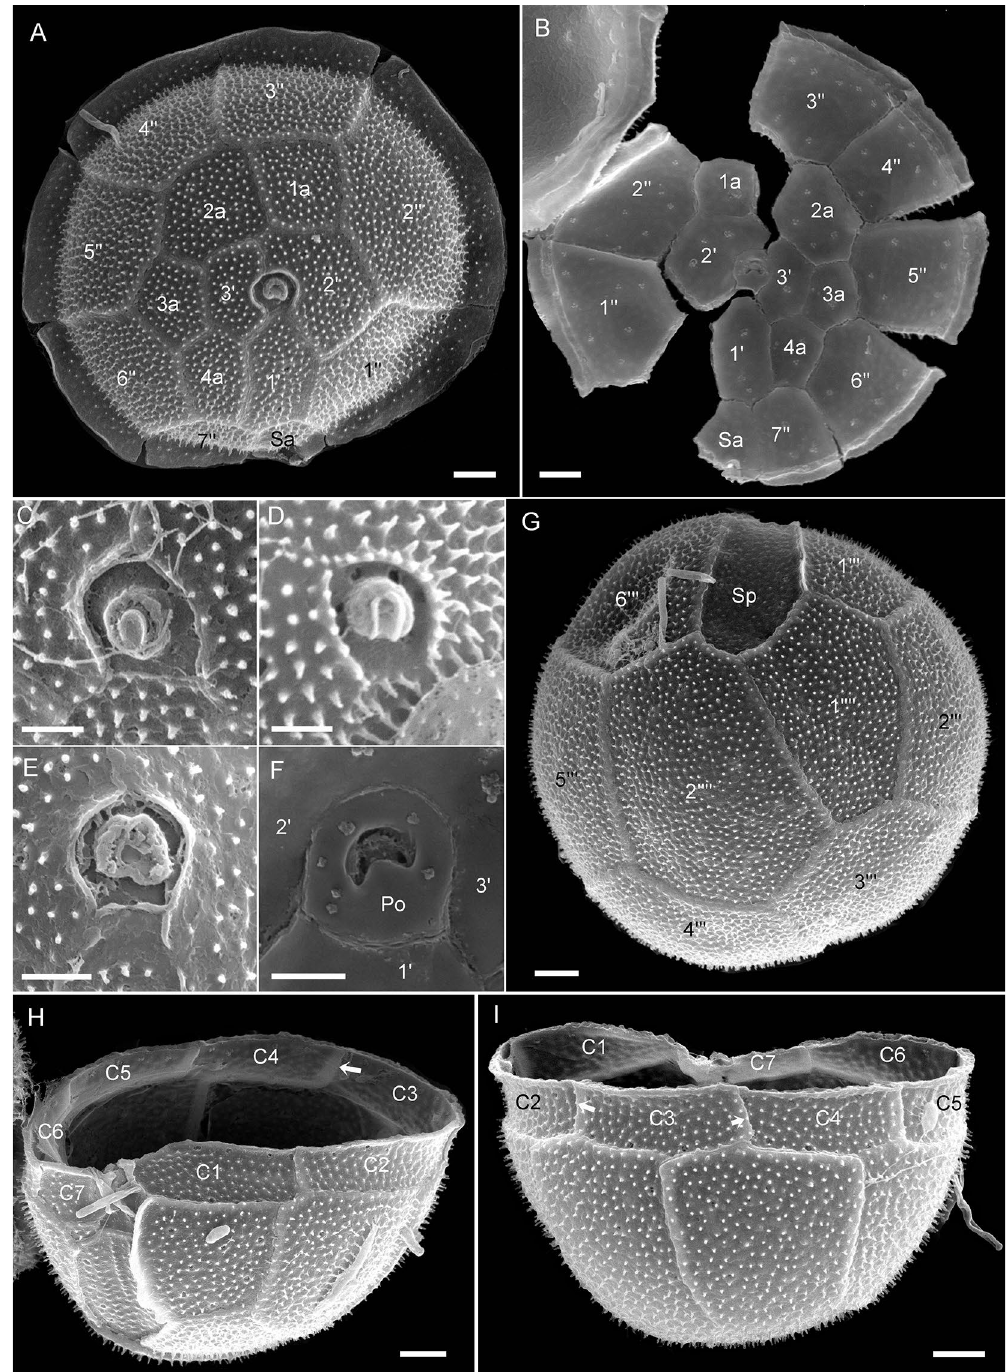
Figure 4. Scanning electron micrographs of Fensomea setacea , gen. & sp. nov . (GeoB*184). ( A , B ) Epitheca from ( A ) external and ( B ) internal views, ( C – F ) detailed view of the apical pore complex externally ( C – E ) or internally ( F ), ( G ) hypotheca in antapical view, ( H – I ) hypotheca in ( H ) ventral lateral view or ( I ) in dorsal view to indicate cingular plates. Scale bars = 2 µm ( A , B , G – I ) or 1 µm ( C – F